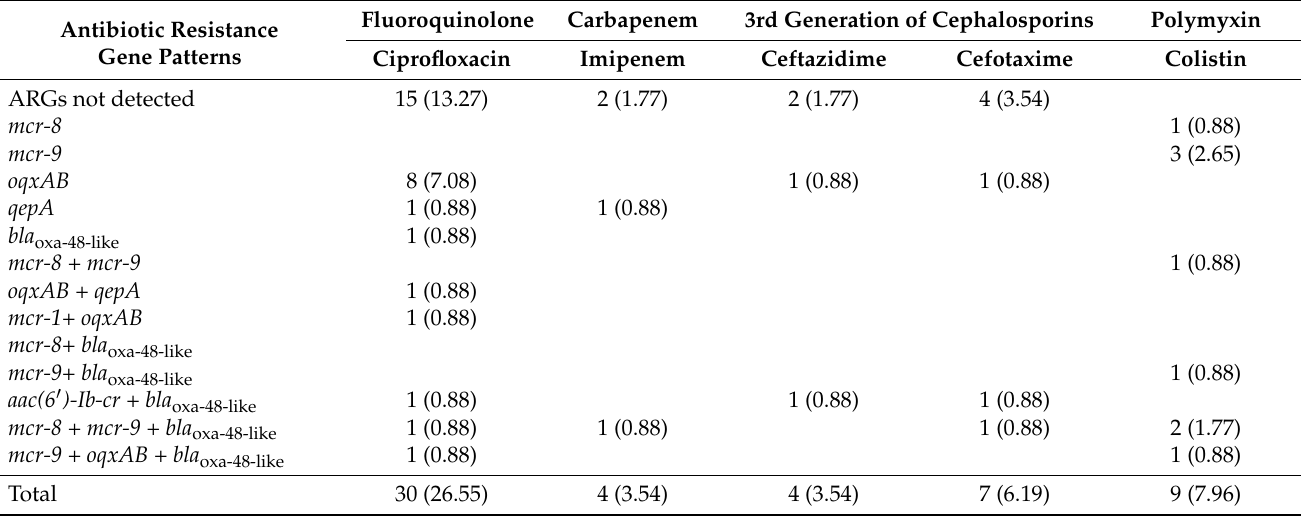
Table 3. Relationships between the antibiotic resistance of the E. coli isolates ( n = 113) and the resistance genes.